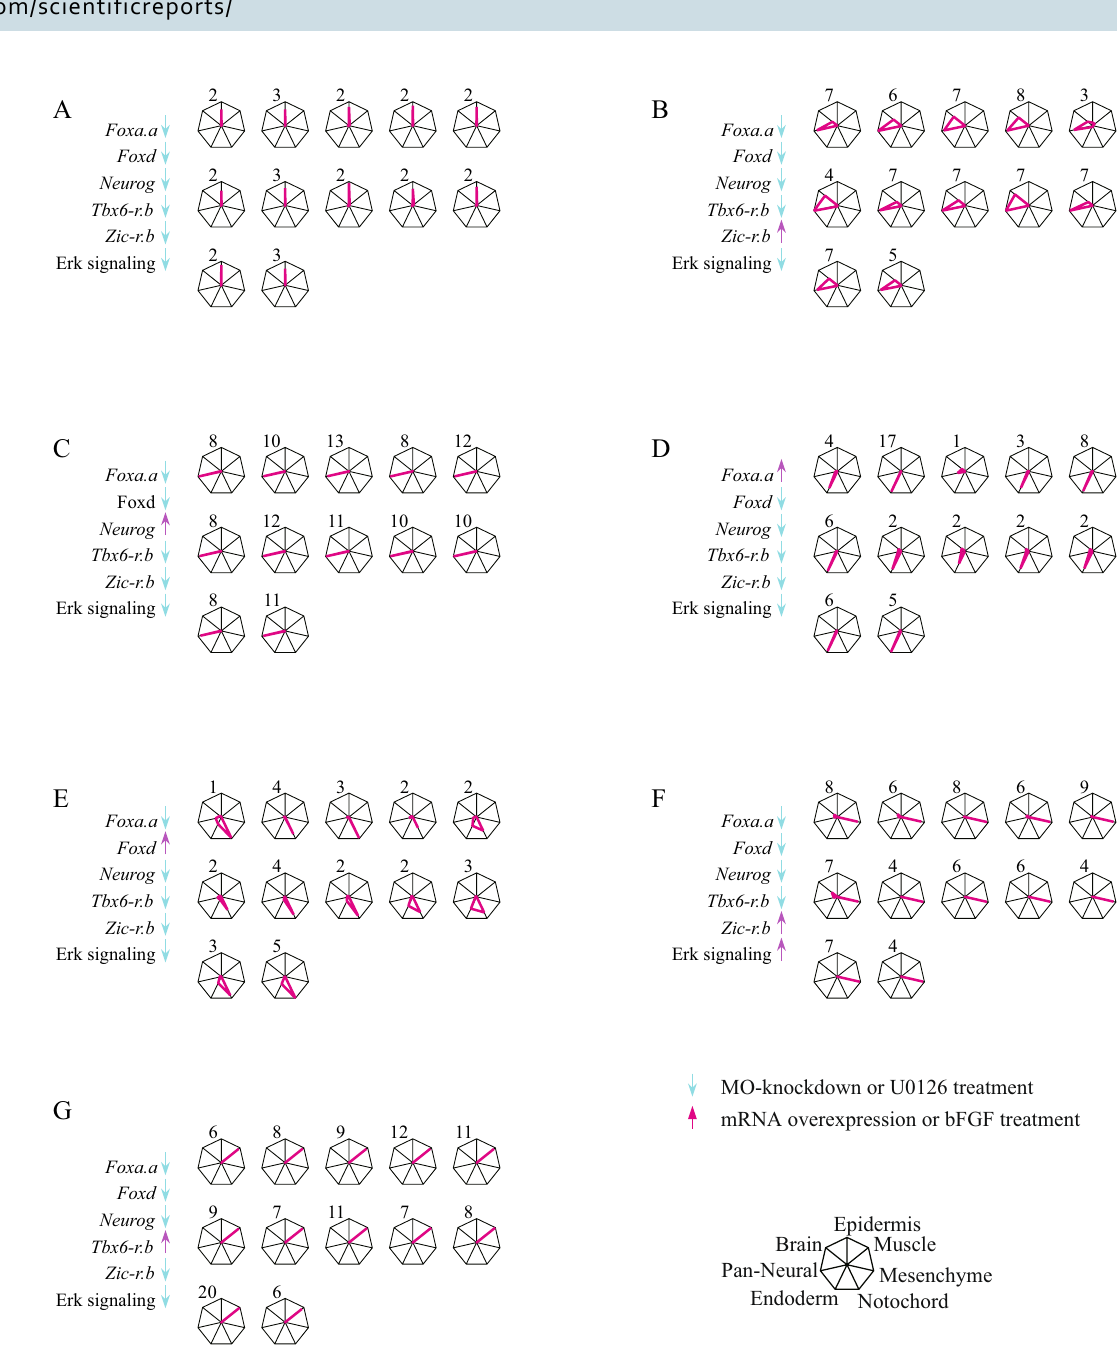
Figure 5. Gene expression in individual embryos in which cell fate is reprogrammed by manipulating activities of FVS factors under a multi-cellular condition. FVS factors are up- or down-regulated in seven different combinations, as shown at the left of each panel. Radar graphs show expression levels of marker genes relative to their corresponding values in normal 9.5-h (tailbud) embryos. Each axis shows expression of a tissue marker, as shown at the bottom right. Values for twelve individual embryos, used for calculation of the mean values in Fig. 4B, are shown in each condition. Note that brain cells express the brain and pan-neural